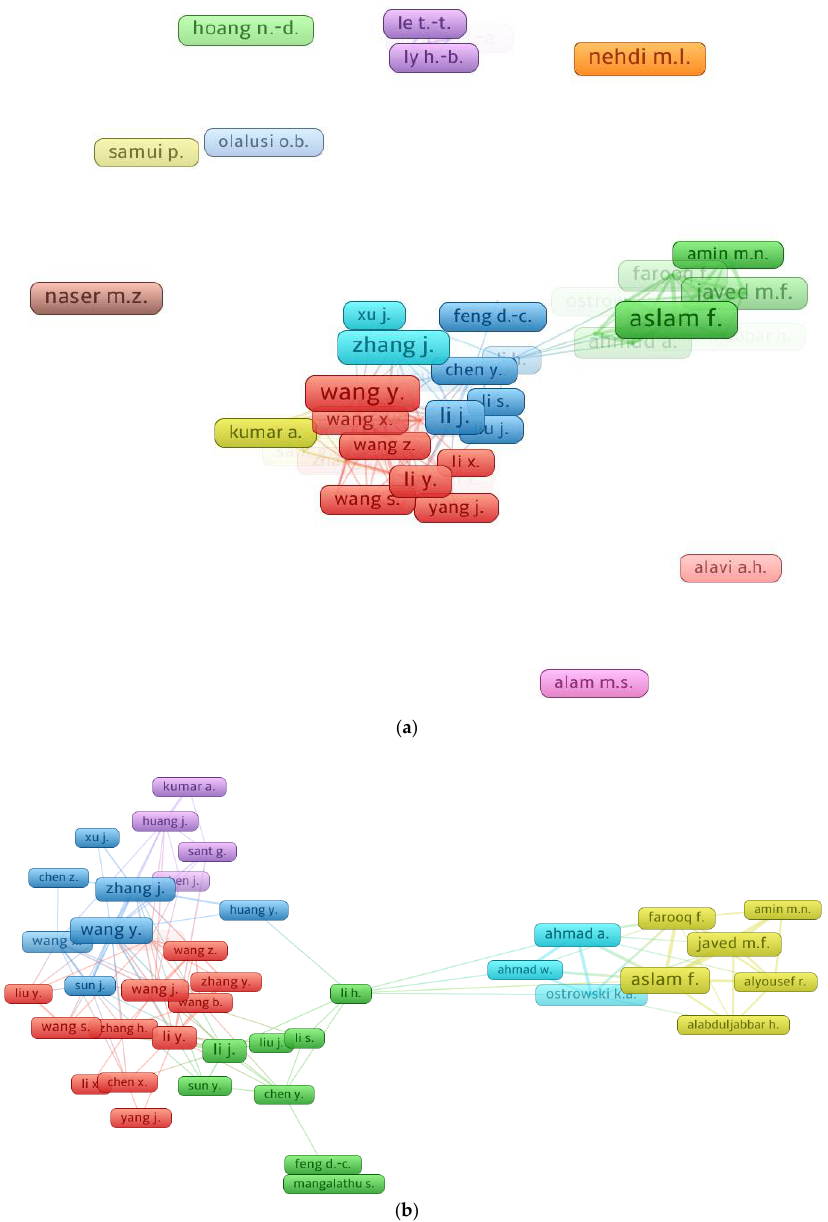
Figure 8. Systematic map of researchers: ( a ) authors with a least 7 articles; ( b ) connected authors.